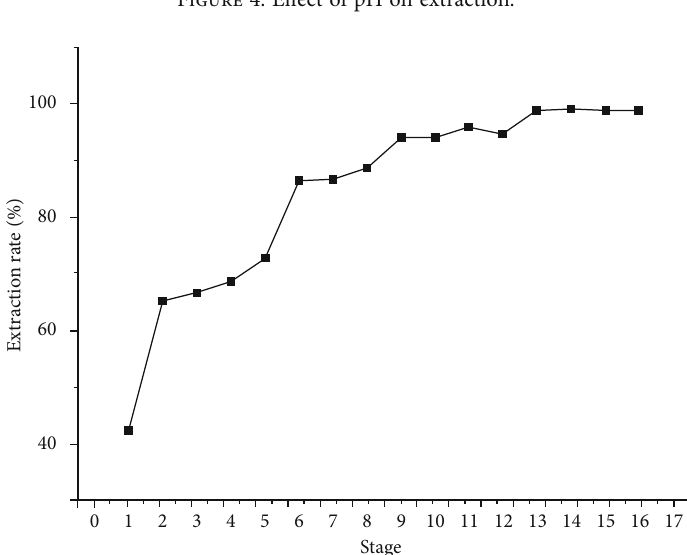
Figure 4: E ff ect of pH on